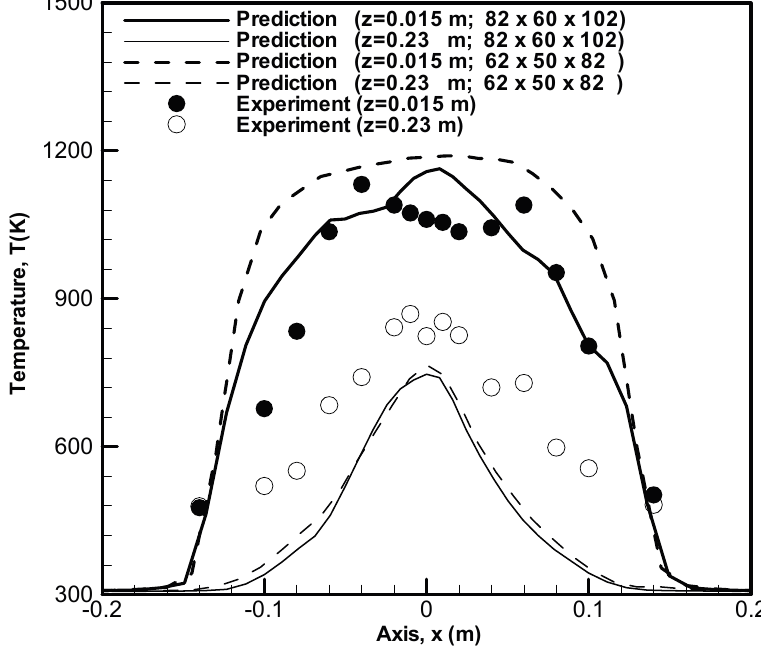
Figure 3. Profiles of the measured and predicted temperature at z = 0.015 and 0.23